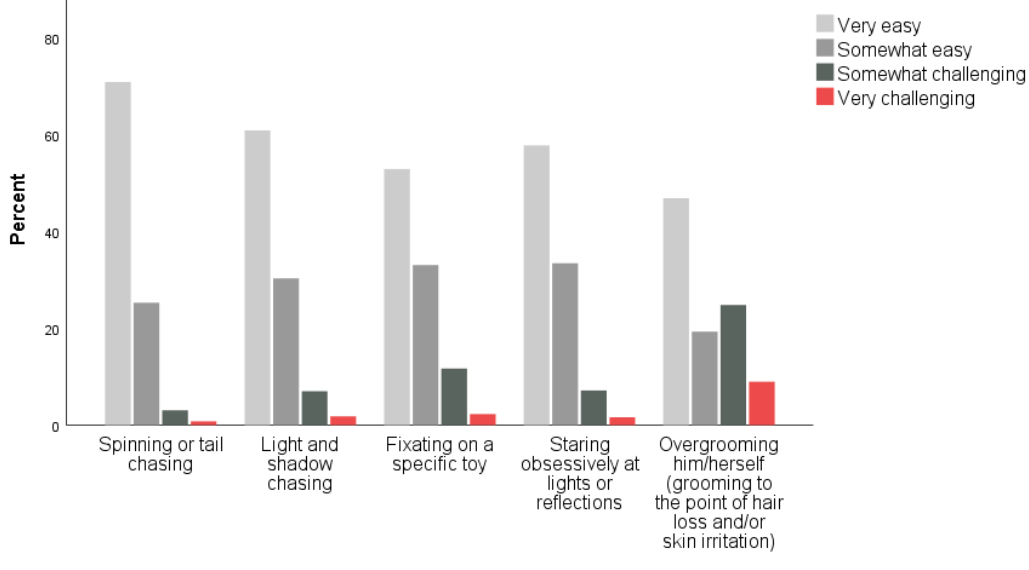
Figure 2. Cat guardian responses to questions related to their ability to redirect their cat’s behavior.